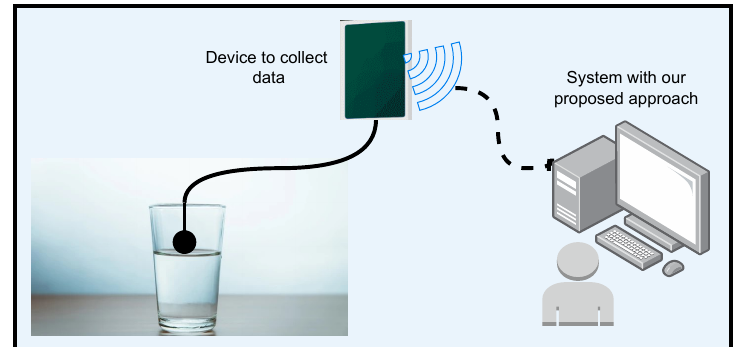
Figure 11. Real-world water quality prediction application of the proposed